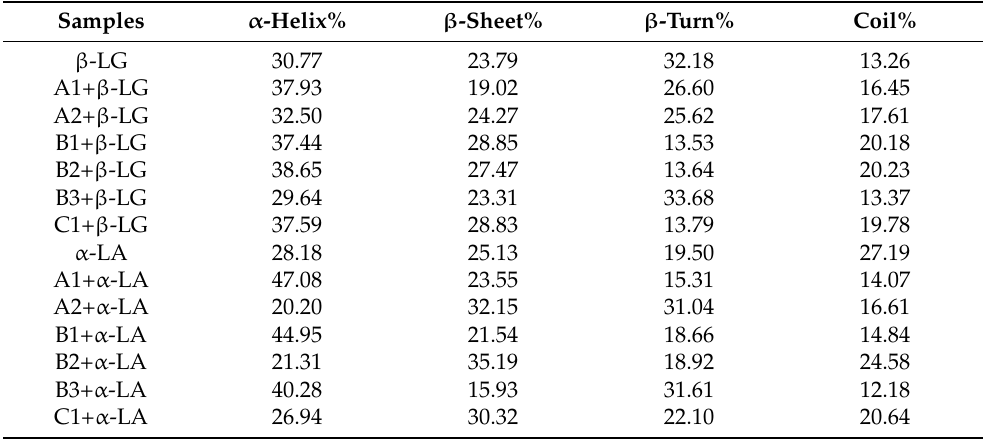
Table 3. Secondary structure analysis for β -LG/ α -LA and their complexes with A1, A2, B1, B2, B3, and C1 by second derivative FTIR